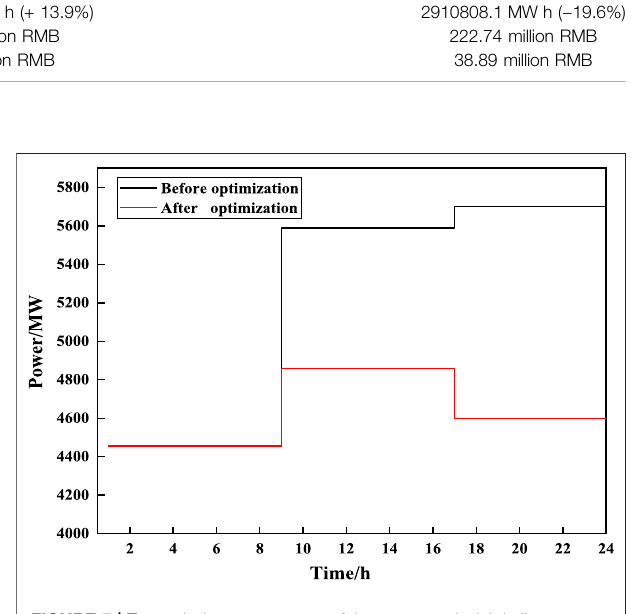
FIGURE 7 | Transmission power curve of the trans-provincial tie-line.